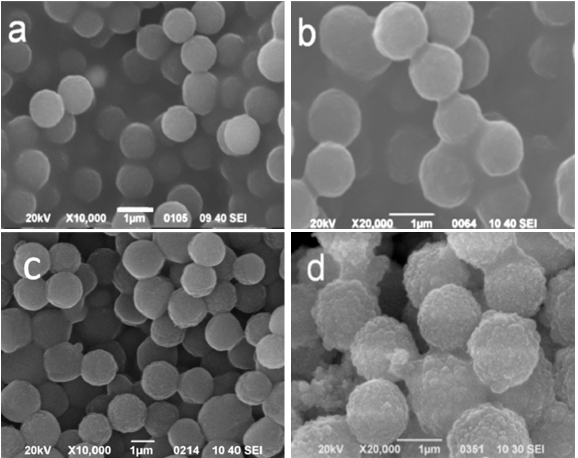
Figure 3. SEM images of ( a ) MF template microspheres and the MF@C-TiO 2 intermediate spheres derived from tetrabutyl titanate (TBOT) ethanol solution of different concentrations: ( b ) 1 vol %; ( c ) 2 vol %; ( d ) 3 vol %.